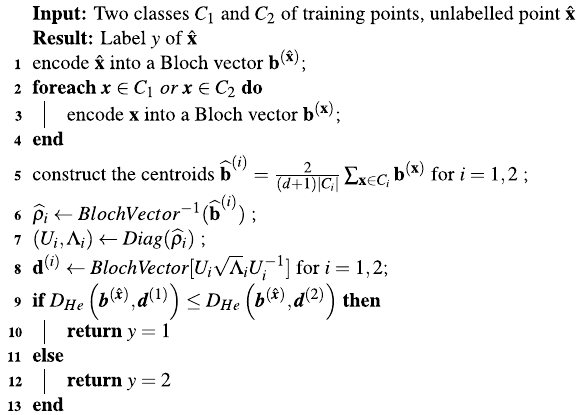
Algorithm 2 : Quantum-inspired nearest mean classifier based on Hellinger